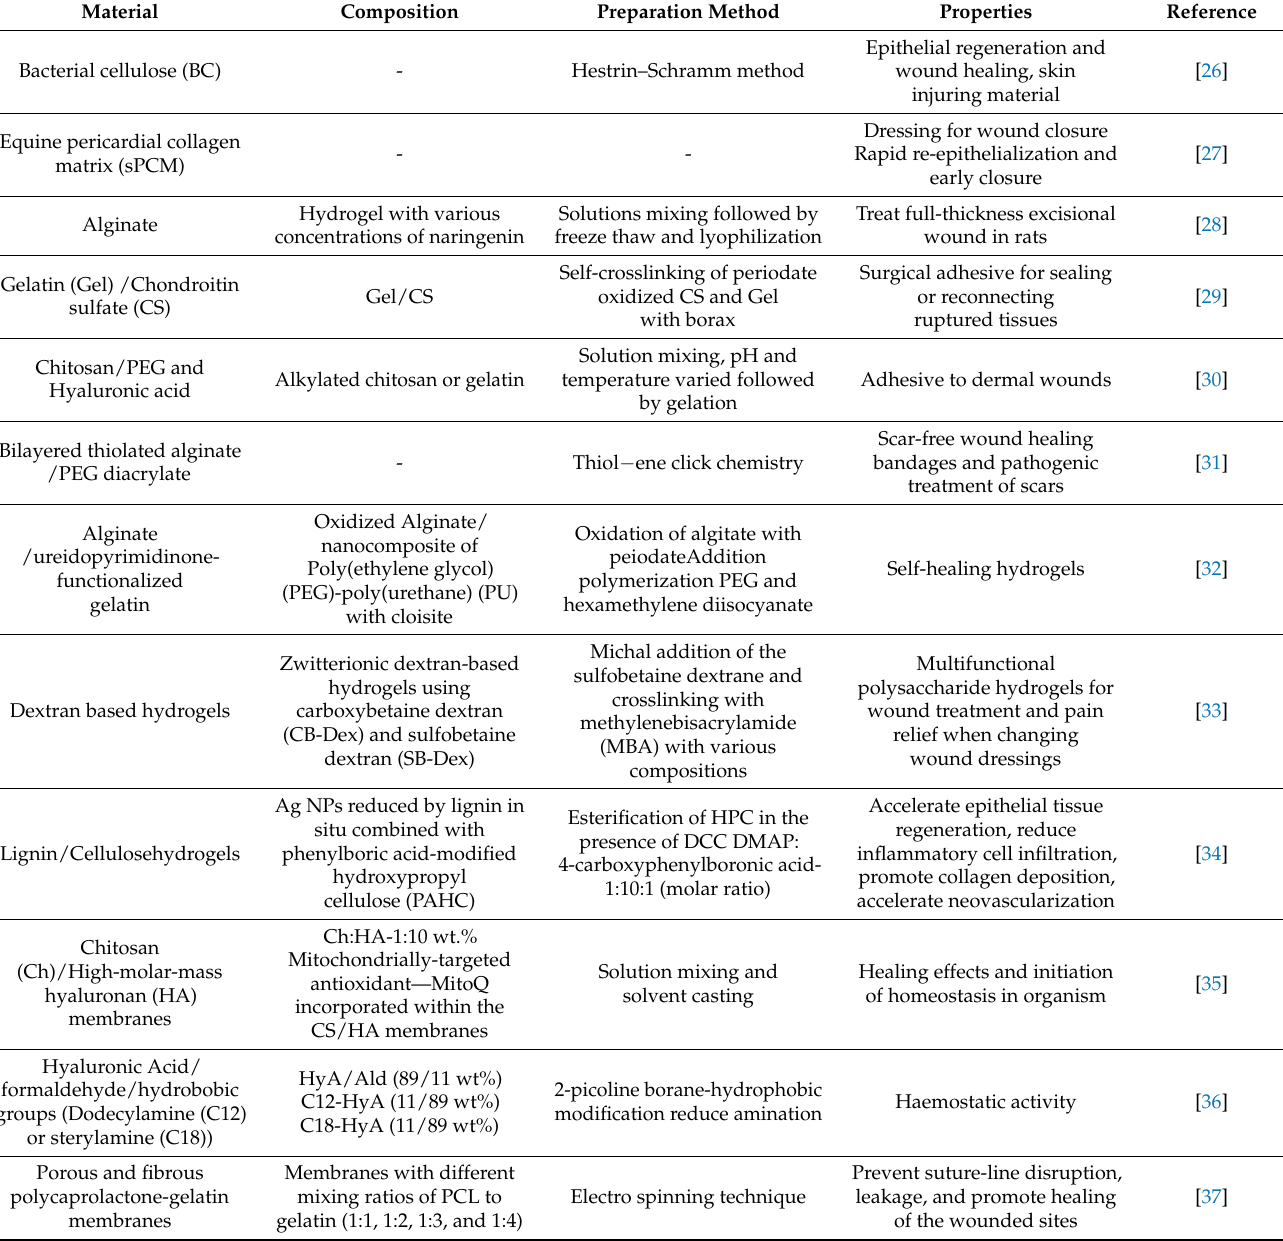
Table 1. Examples of the use of biopolymers in surgical